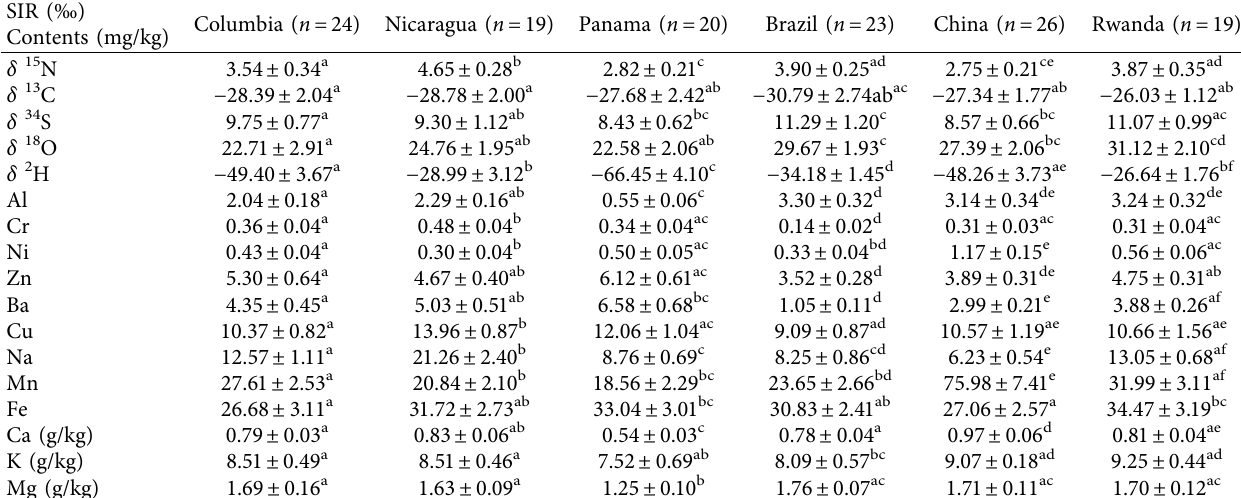
Table 4: Te mean ± standard error value of fve stable isotopes and twelve elements of green cofee beans from six diferent origins. SIR (‰)